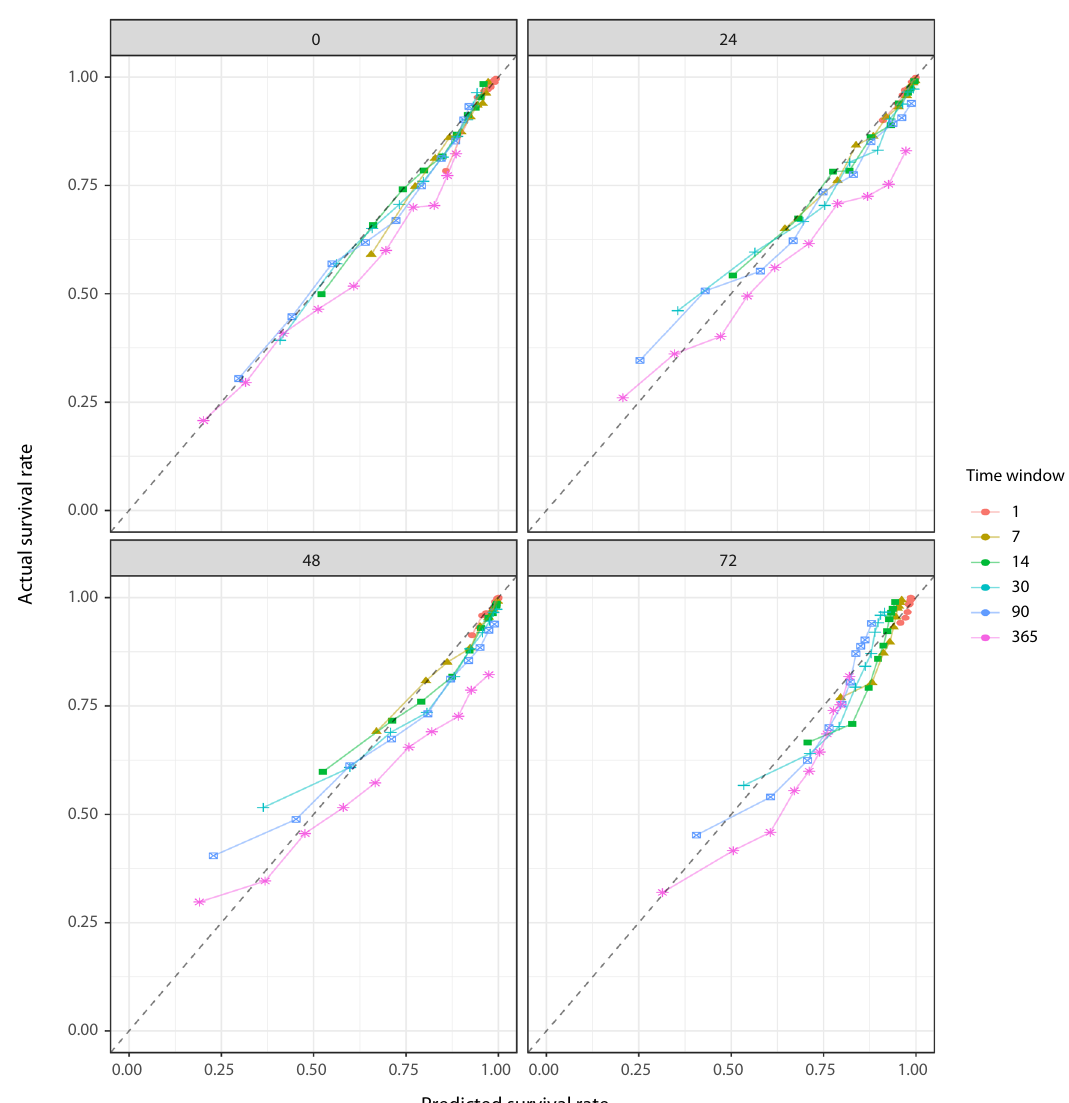
Fig. 3 Calibration plots. Observed survival rates estimated by the Kaplan – Meier survival estimates method is plotted against predicted survival rates for baseline equal to 0 (i.e., “ door-step ” ), 24, 48, and 72 h. Each prediction window (1, 7, 14, 30, 90, and 365 days have its own curve). The diagonal represents perfect